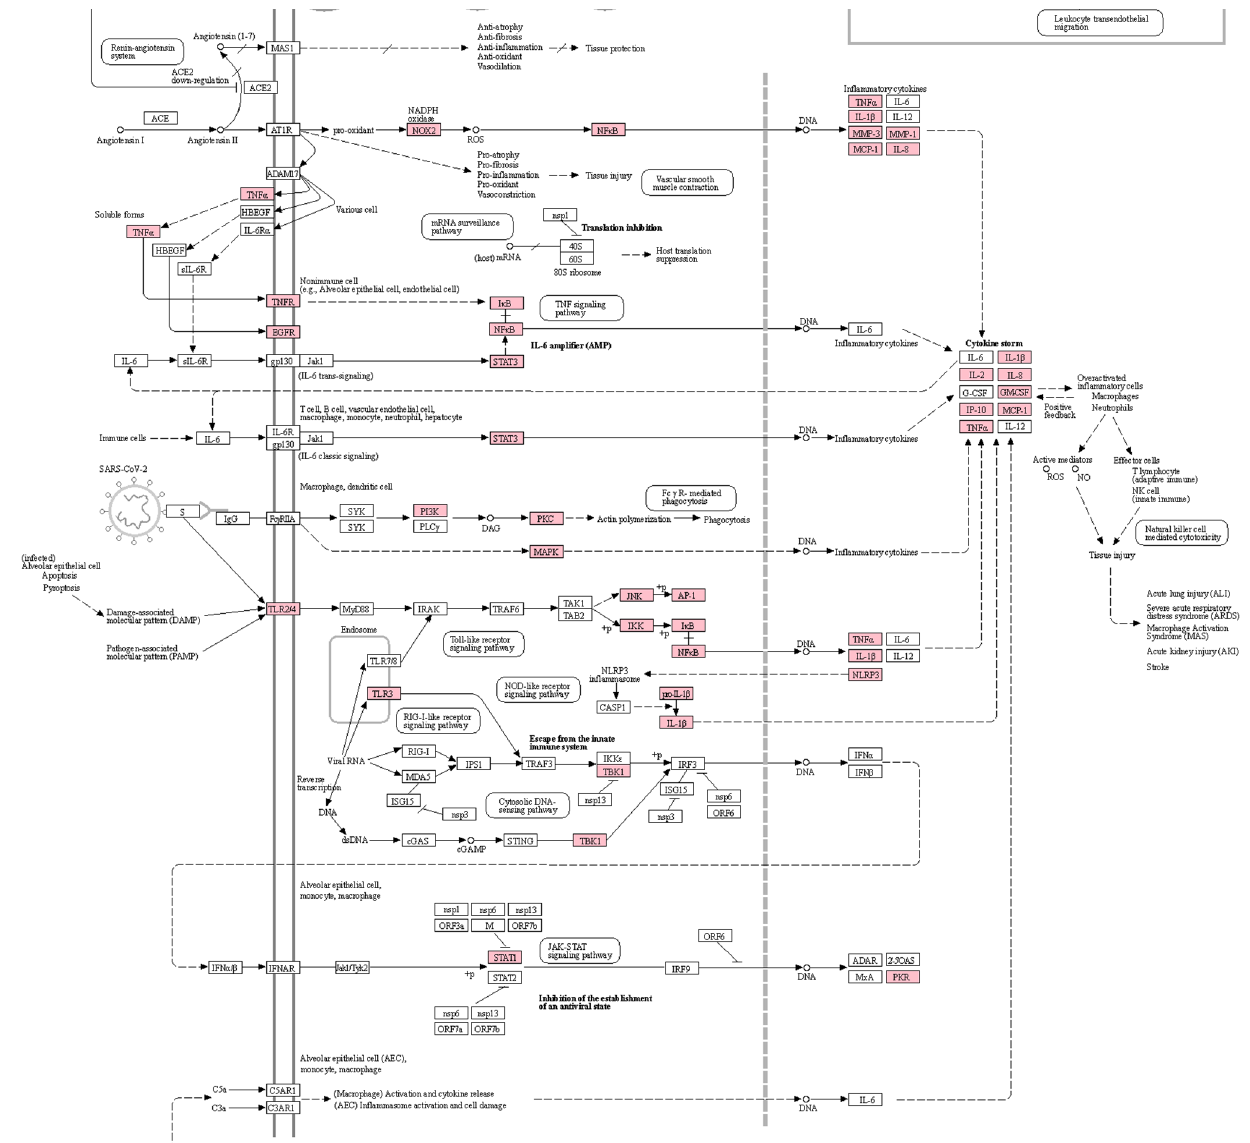
Figure 2. A pathway for coronavirus diseases highlighting the potential targets of the drug combination. Boxes and arrows between them indicate the proteins that consist of the pathway and interactions between the proteins, respectively. Pink-colored boxes indicate the targets of the drug combination. The graph image was generated by a KEGG mapper and cropped by the authors because of the page limit. The uncropped image is shown in Supplementary Figure S1.